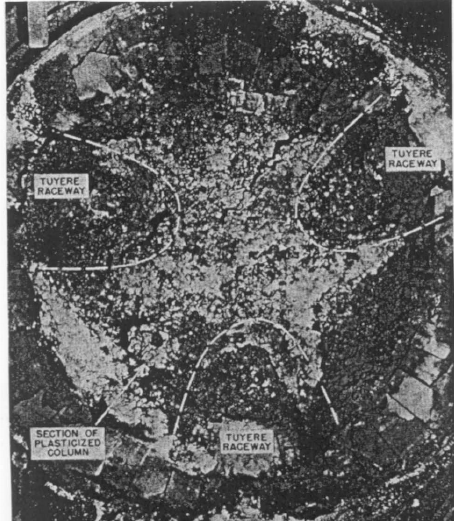
Figure 1. Photograph of the frozen tuyere zone. Reproduced with permission from [4], Springer, 1987.